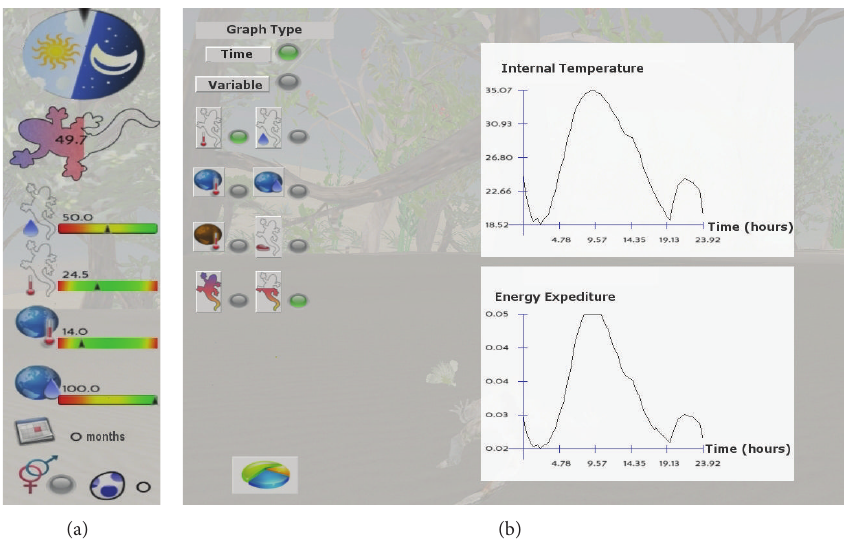
Figure 11: During game execution, the player has access to instant values of various simulated variables (a) and also to changes along time of these variables by means of a graph generator interface (b).